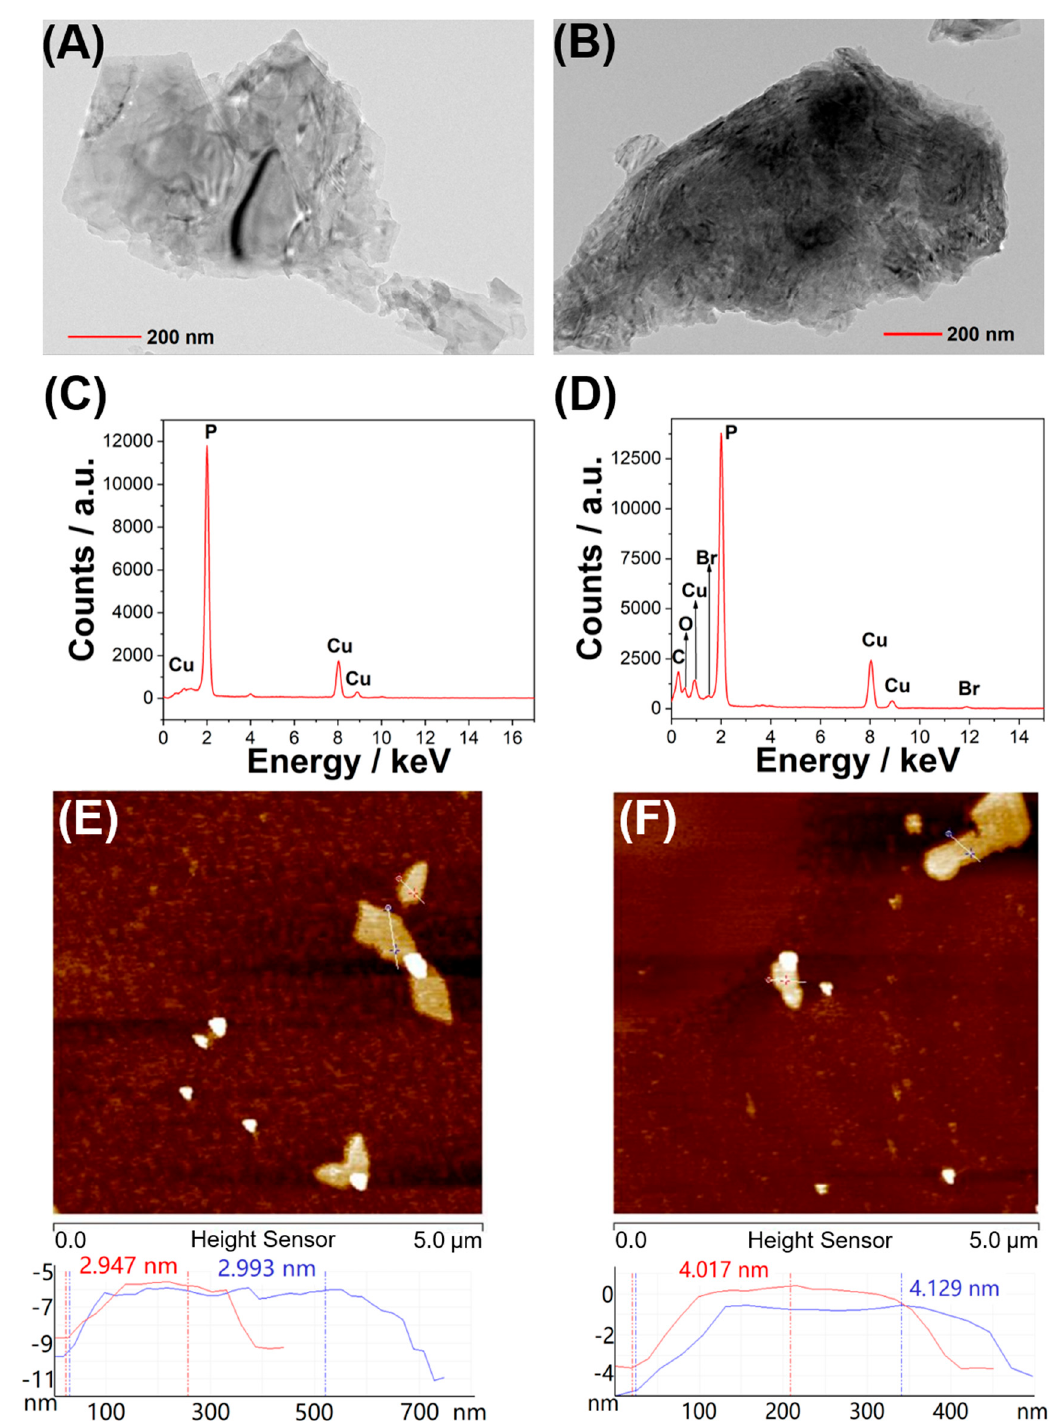
Figure 7. Transmission Electron Microscope (TEM) images of BPNS ( A ) and BPNS@cPA6 ( B ). Energy dispersive X-ray spectrometry (EDX) analysis of BPNS ( C ) and BPNS@cPA6 ( D ). Atomic force microscopy (AFM) images of BPNS ( E ) and BPNS@cPA6 ( F ).